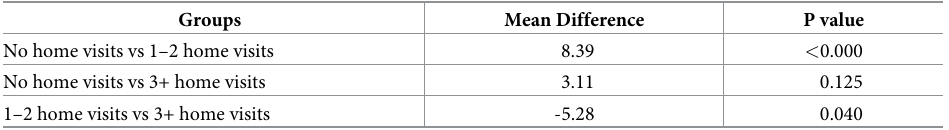
Table 4. Tukey Post hoc comparison of groups on knowledge